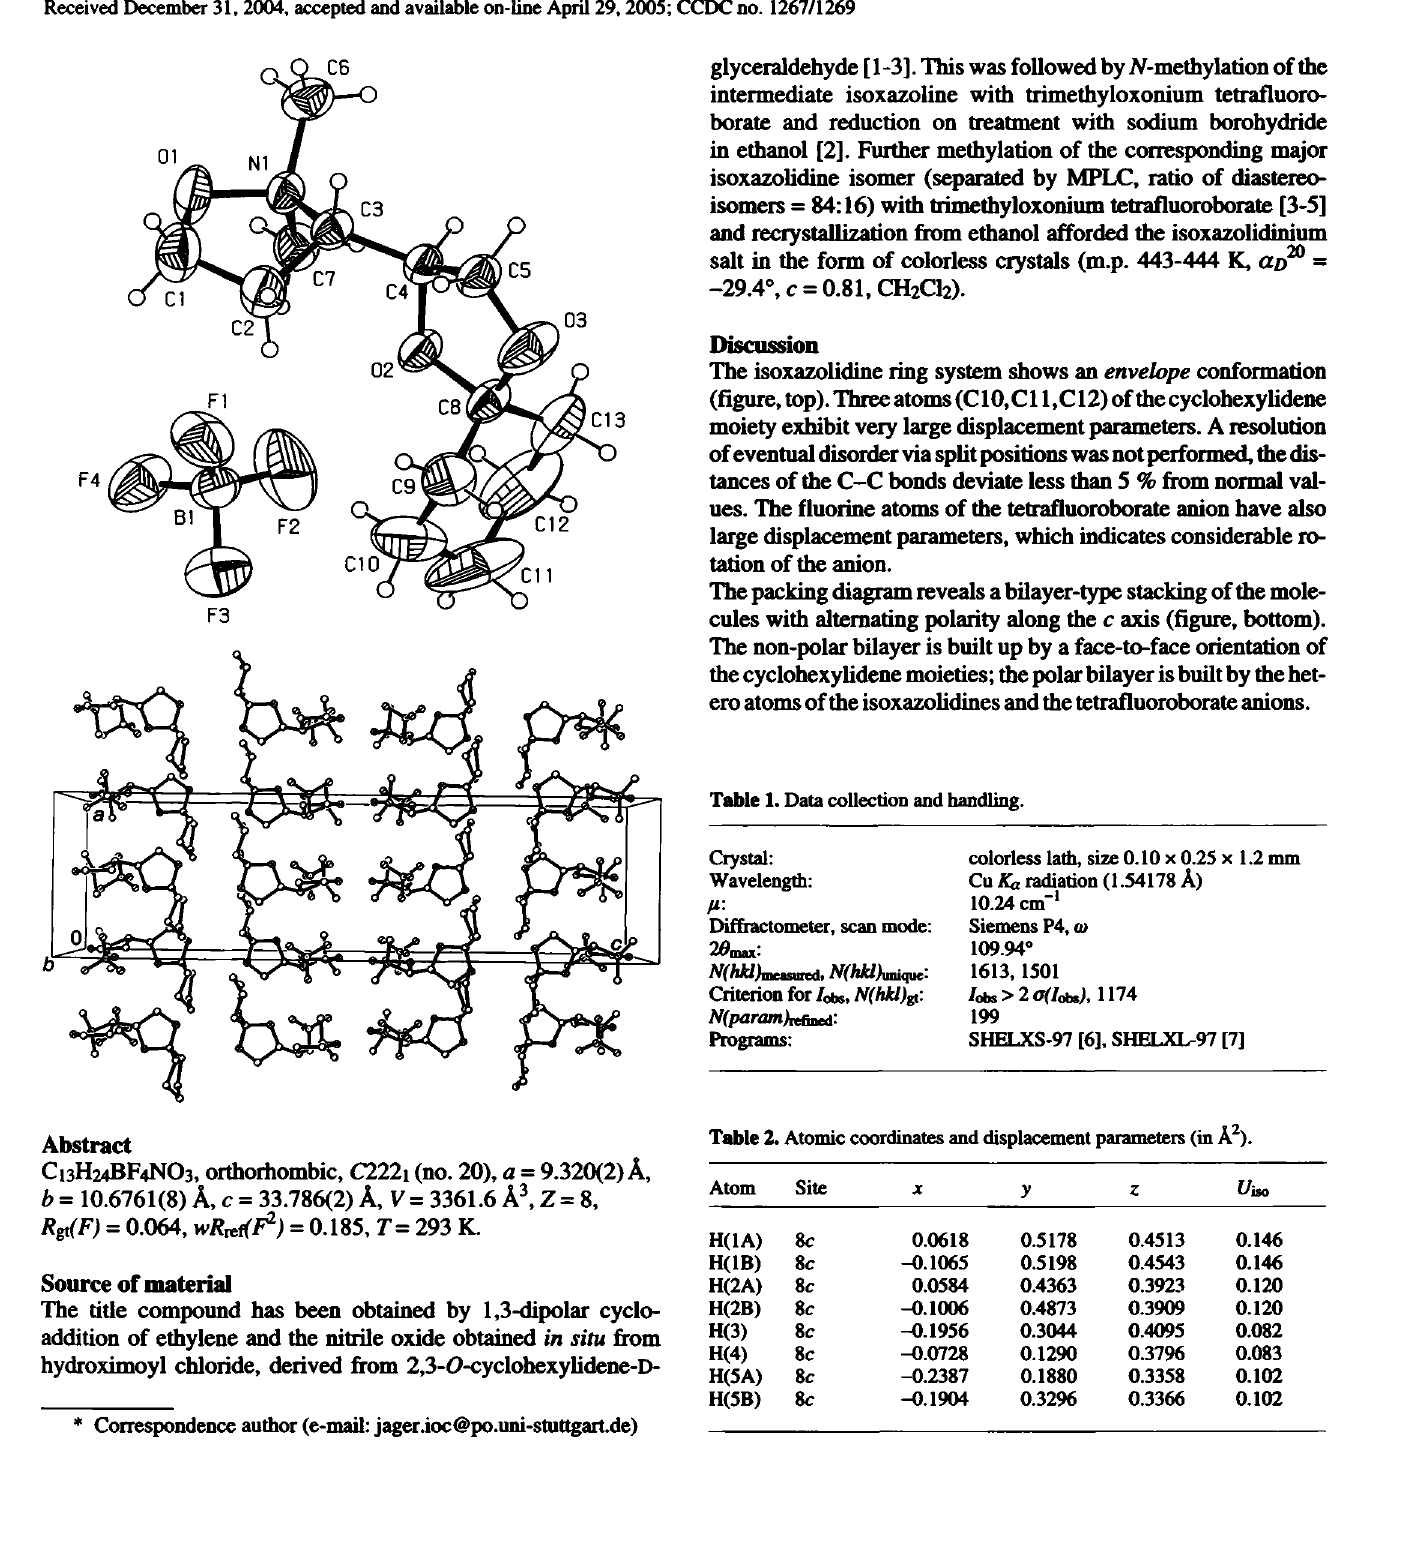
Table 2. Atomic coordinates and displacement parameters (in Ä 2